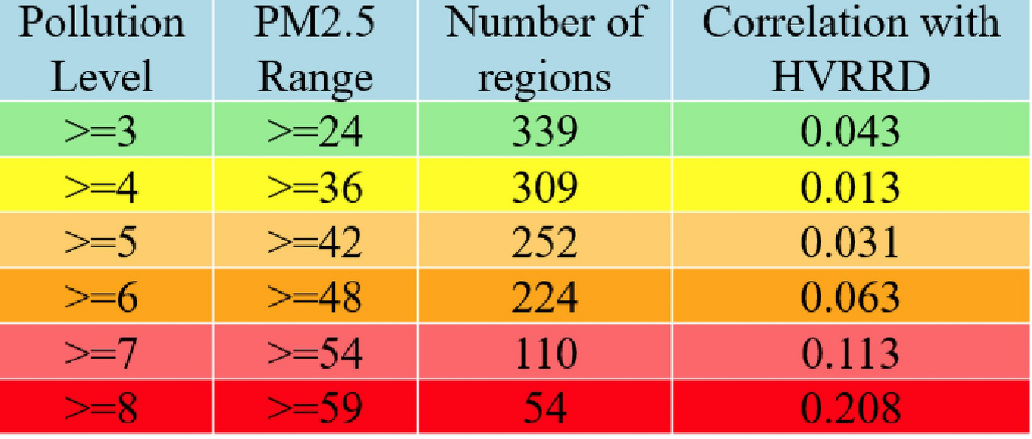
Fig 3. Correlations between hospital visit rates and PM 2.5 under different pollution levels.